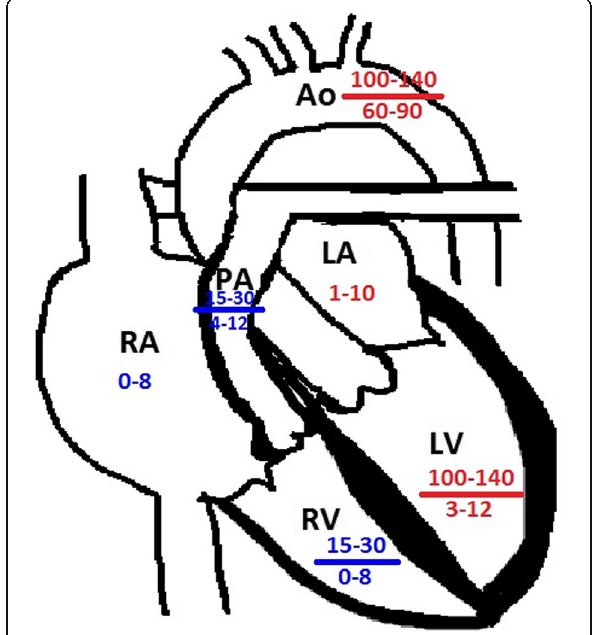
Fig. 2 Right and left heart pressures. Diagram demonstrates the right (blue) and left (red) heart pressures